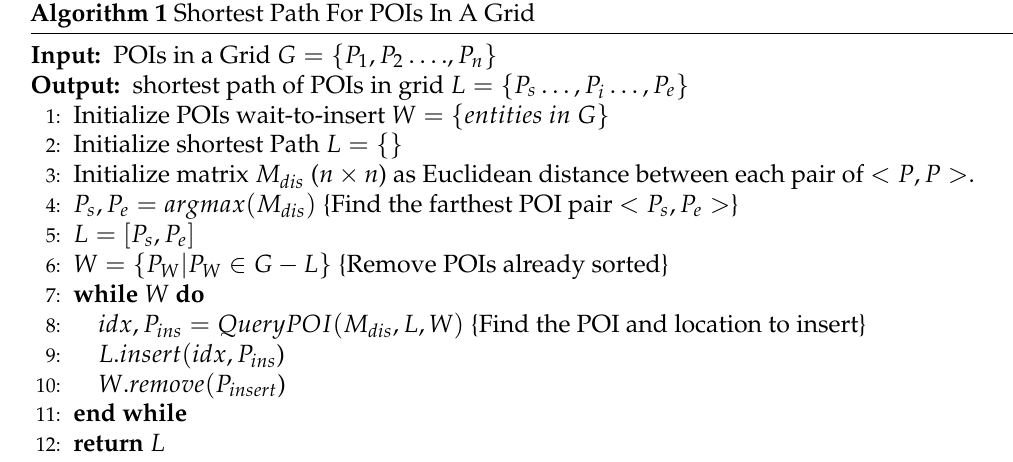
Algorithm 1 Shortest Path For POIs In A